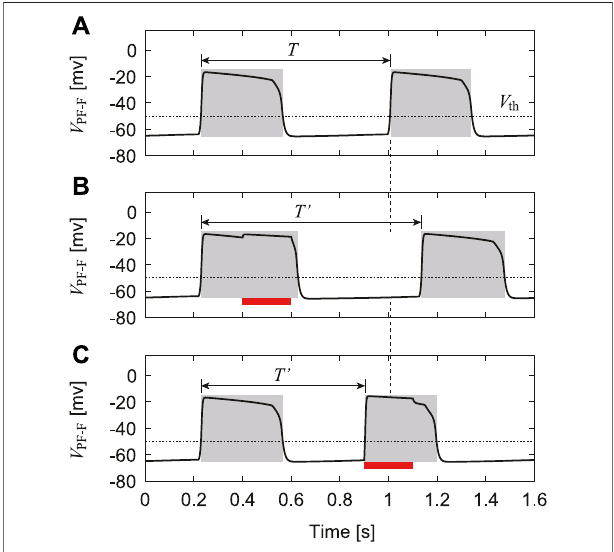
FIGURE 3 | Change in membrane potential of PF-F neuron by stimulation: (A) No stimulation. (B) Stimulation to the fl exor side during the active phase, which increases the duration of the current active phase and cycle ( T ′ > T ). (C) Stimulation to the fl exor side during the silent phase, which initiates the active phase and decreases the cycle duration ( T ′ < T ). Red bars indicate the application of stimulation. Gray regions indicate active